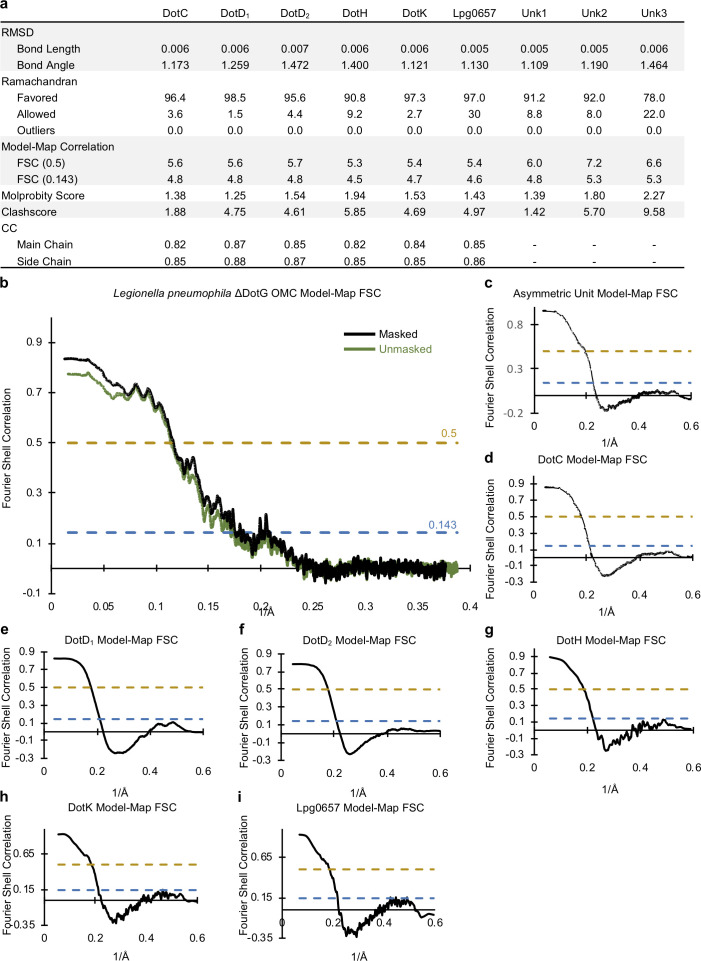
Correlation between the Lp ΔDotG OMC cryo-EM map and models.(a) Statistics for each model that was constructed indicate their relative quality. (b) A model-map correlation curve for the entire Lp ΔDotG OMC is shown with the unmasked data shown in green and the masked data shown in black. (c–i) The model-map correlation was also determined for each individual protein structure that was solved within the Lp ΔDotG OMC.